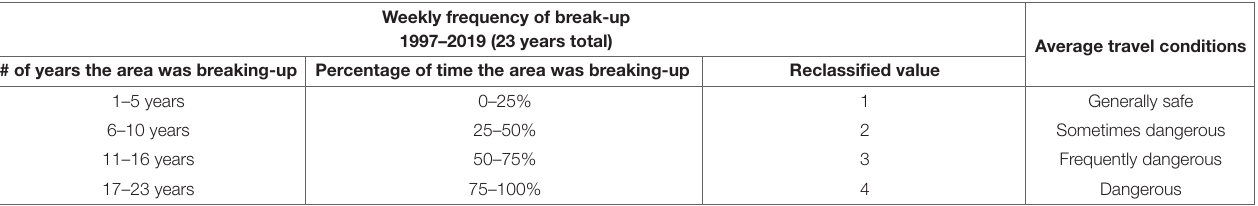
TABLE 3 | Weekly average break-up map categories.